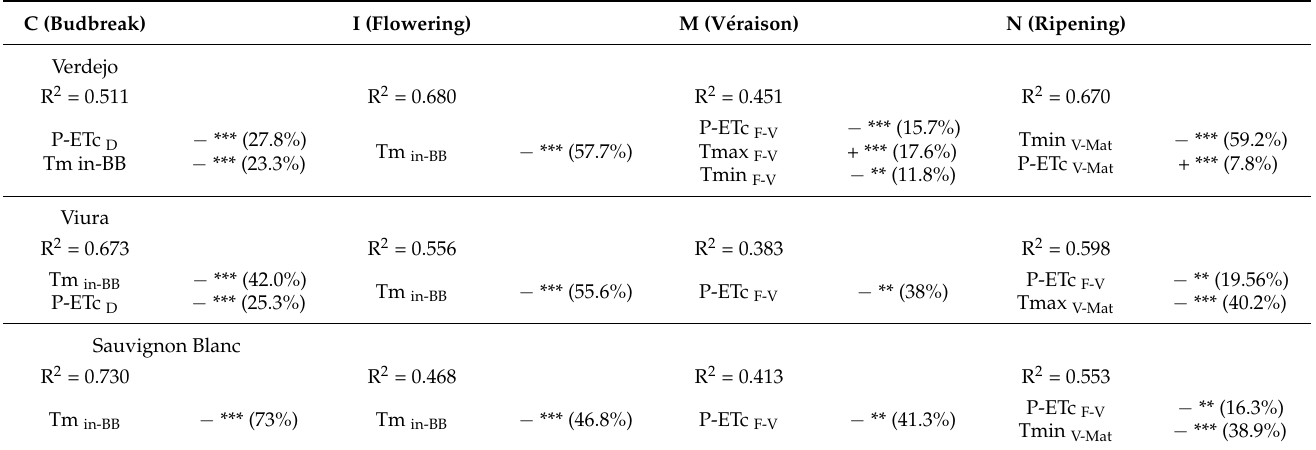
Table 1. Climatic variables that correlated significantly in a multiple regression analysis with phe- nological dates for the three analysed varieties (Verdejo, Viura and Sauvignon Blanc) in Rueda DO. (Tm: mean temperature; Tmax: maximum temperature; Tmin: minimum temperature; P-ETc: